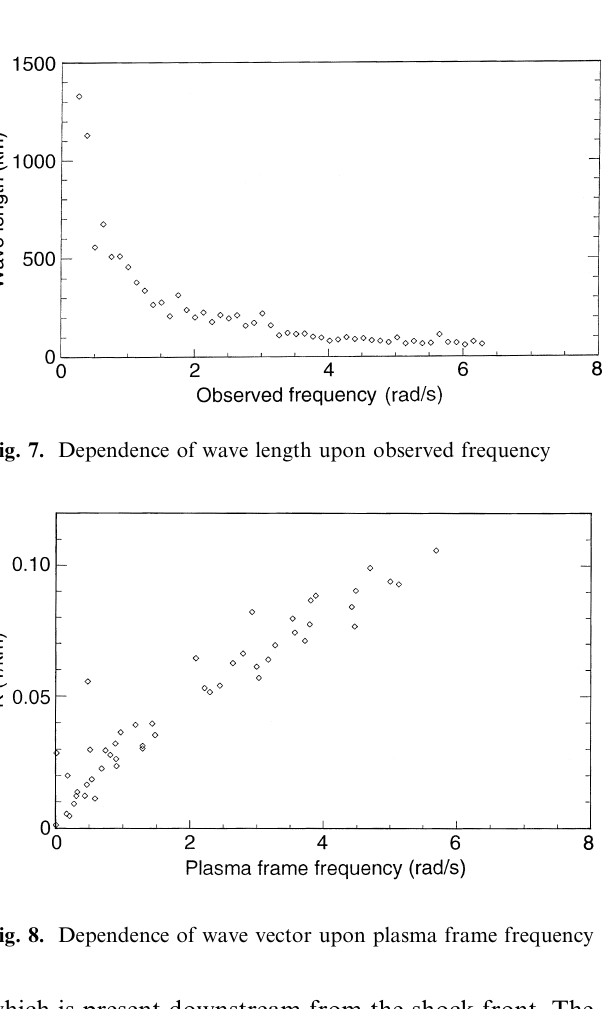
Fig. 6. Dependence of wave vector upon observed frequency